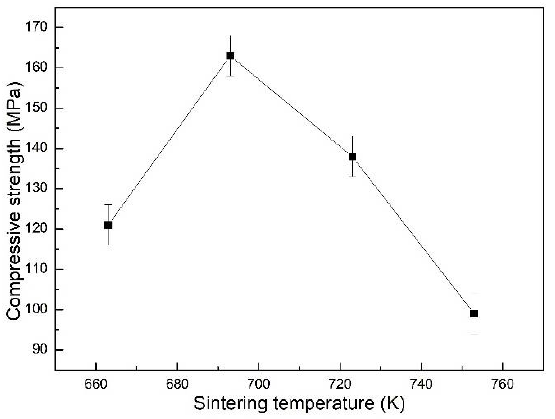
Figure 9. Quasistatic compressive strength of the Al 2 O 3hs /AZ91D syntactic foams.